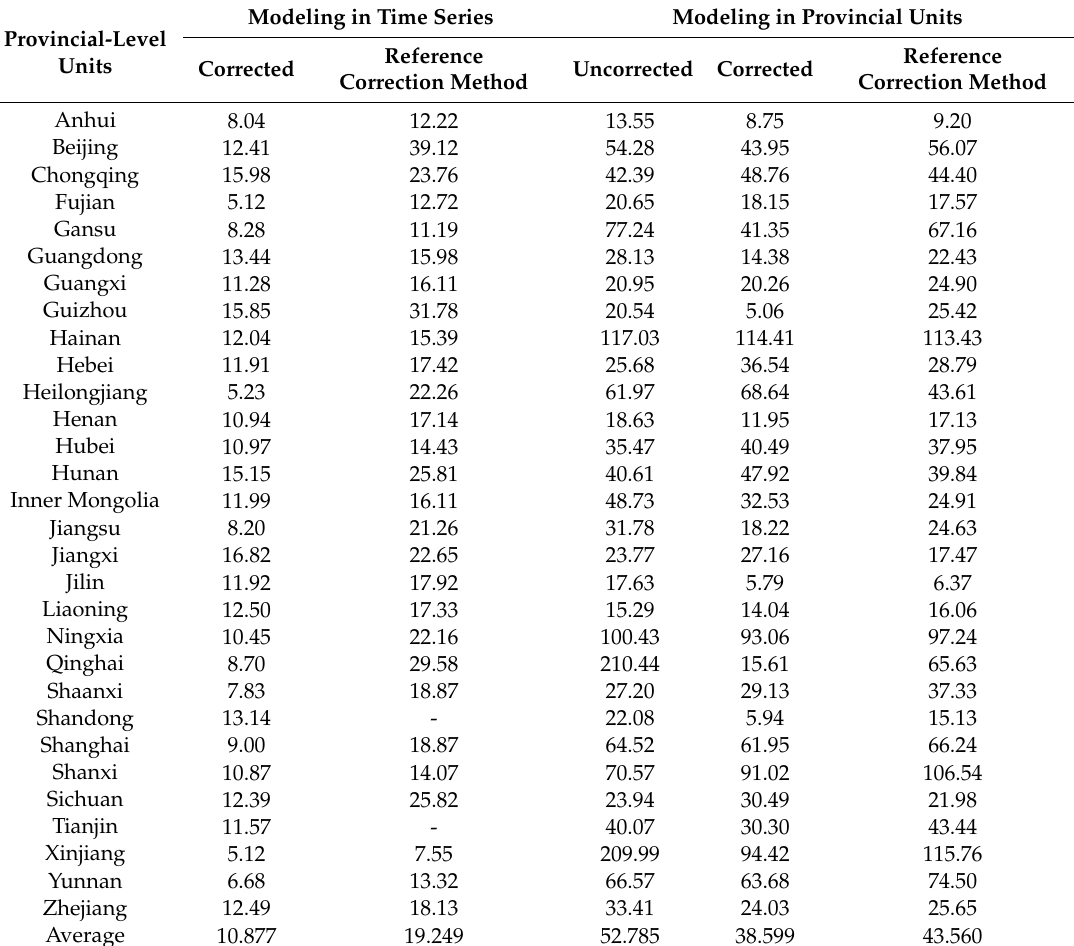
Table 12. MARE of the predicted gross domestic product (GDP) in time series and in provincial units. Modeling in Time Series Modeling in Provincial Units Provincial-Level Units